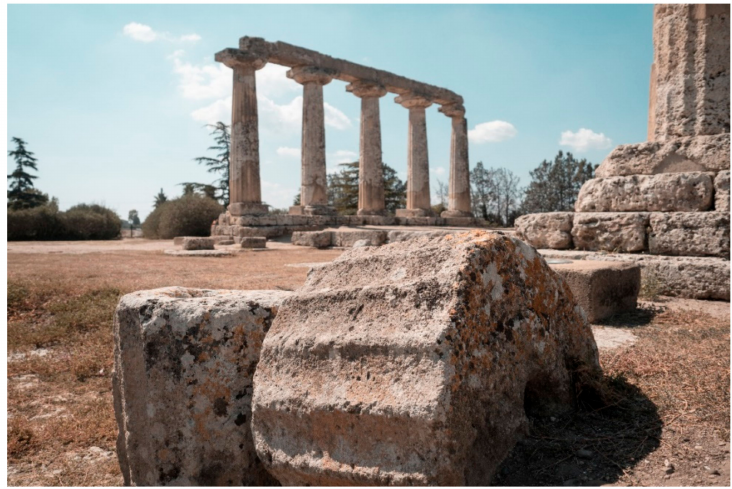
Figure 3. Metaponto: Tavole Palatine (Author: Attilio Bixio, source: https://commons.wikimedia. org/wiki/File:Metaponto_Tavole_Palatine.jpg (accessed on 4 March 2021), license: